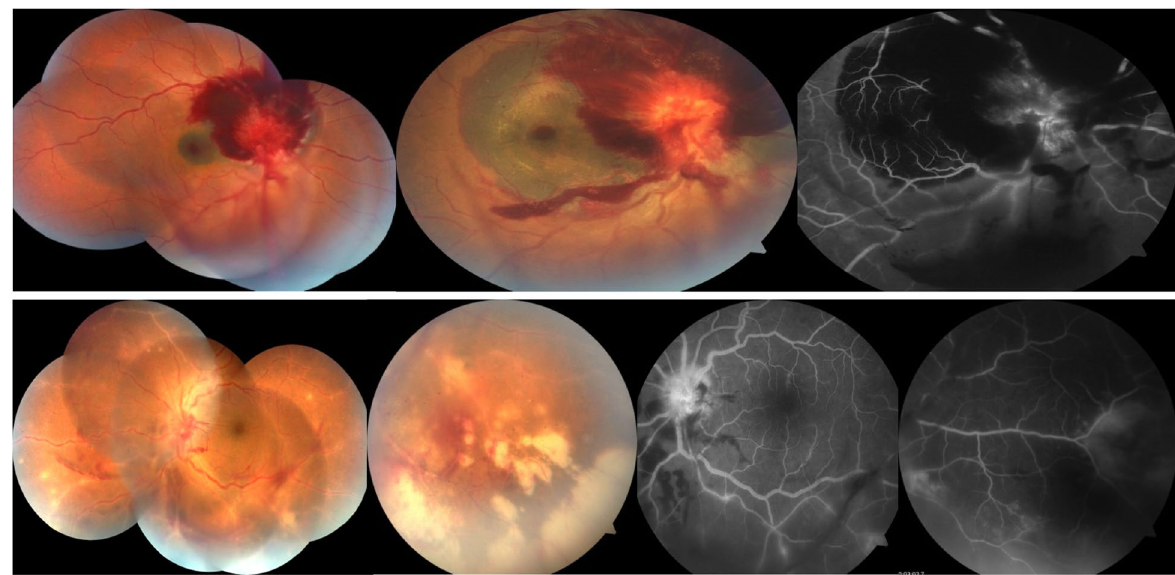
Fig. 1 Clinical picture and FFA on presentation: upper column; Right eye montage and posterior pole colour fundus photos showing severe optic disc edema with multilayered retinal hemorrhages (subretinal, intraretinal and minimal localised inferior vitreous hemorrhage), with clear ocular media and normal retinal periphery. Mid venous phase Fundus fluorescein angiography of the same eye showing swollen leaky optic disc with extensive blockage of the choroidal filling by the multilayered retinal hemorrhages. Lower column; Left eye montage and peripheral colour fundus photos showing extensive retinal vasculitis with peripheral confluent patches of retinitis and satellite retinitis lesions. Fundus Fluorescein angiography of the same eye showing staining and leakage of retinal arteries and optic disc with staining of the peripheral areas of retinitis. Localized blockage of the dye caused by the peripapillary retinal